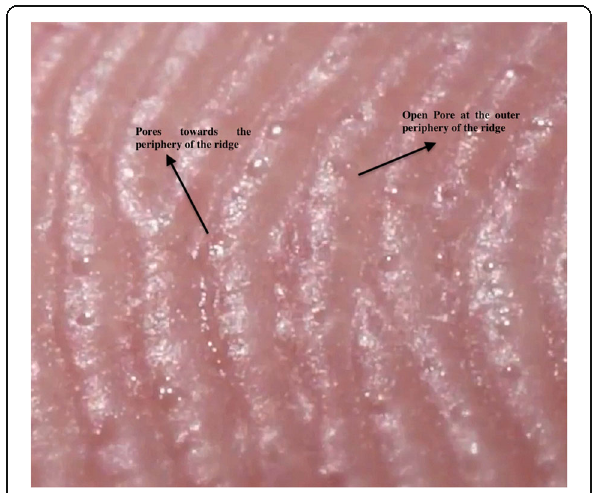
Fig. 3 The photomicrographic image of rolled friction ridge impressions showing different positions (middle and periphery) of pores on the flowing friction ridge of an individual